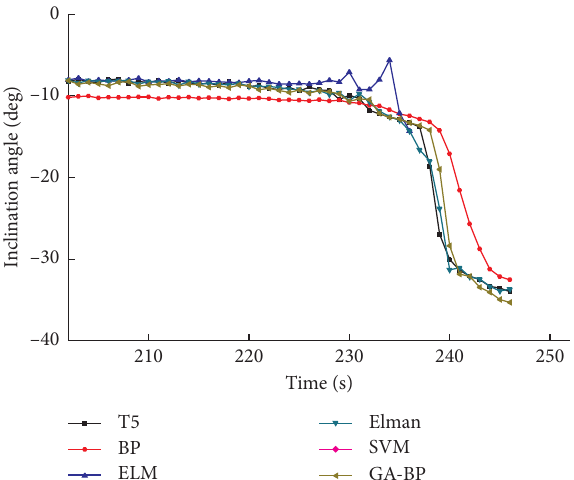
Figure 18: Prediction performance of other models on the in- clination angle of